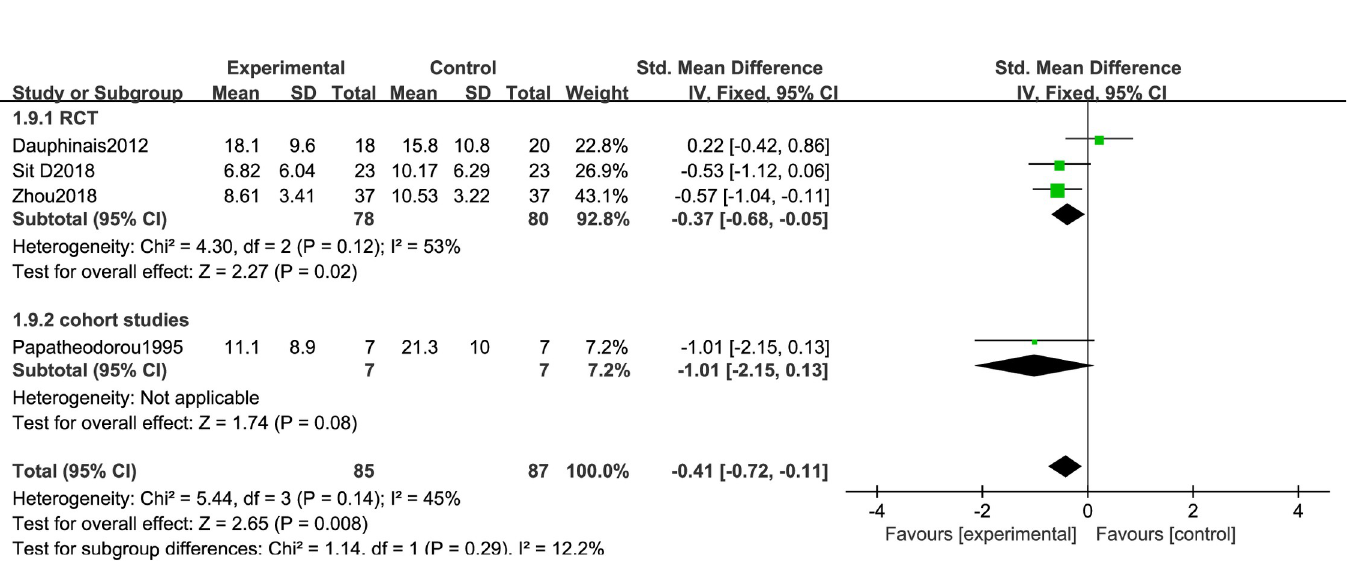
difference between conditions. Different light color were used in the included study, and the effect of different light color on the treatment of patients is inconclusive. Therefore, we performed a meta-analysis of stud- ies that used different light color. 7 articles were include: 2RCTs [50,51] and 5 cohort studies [53–56,61], that were discussed separately according to the study design. We found that white